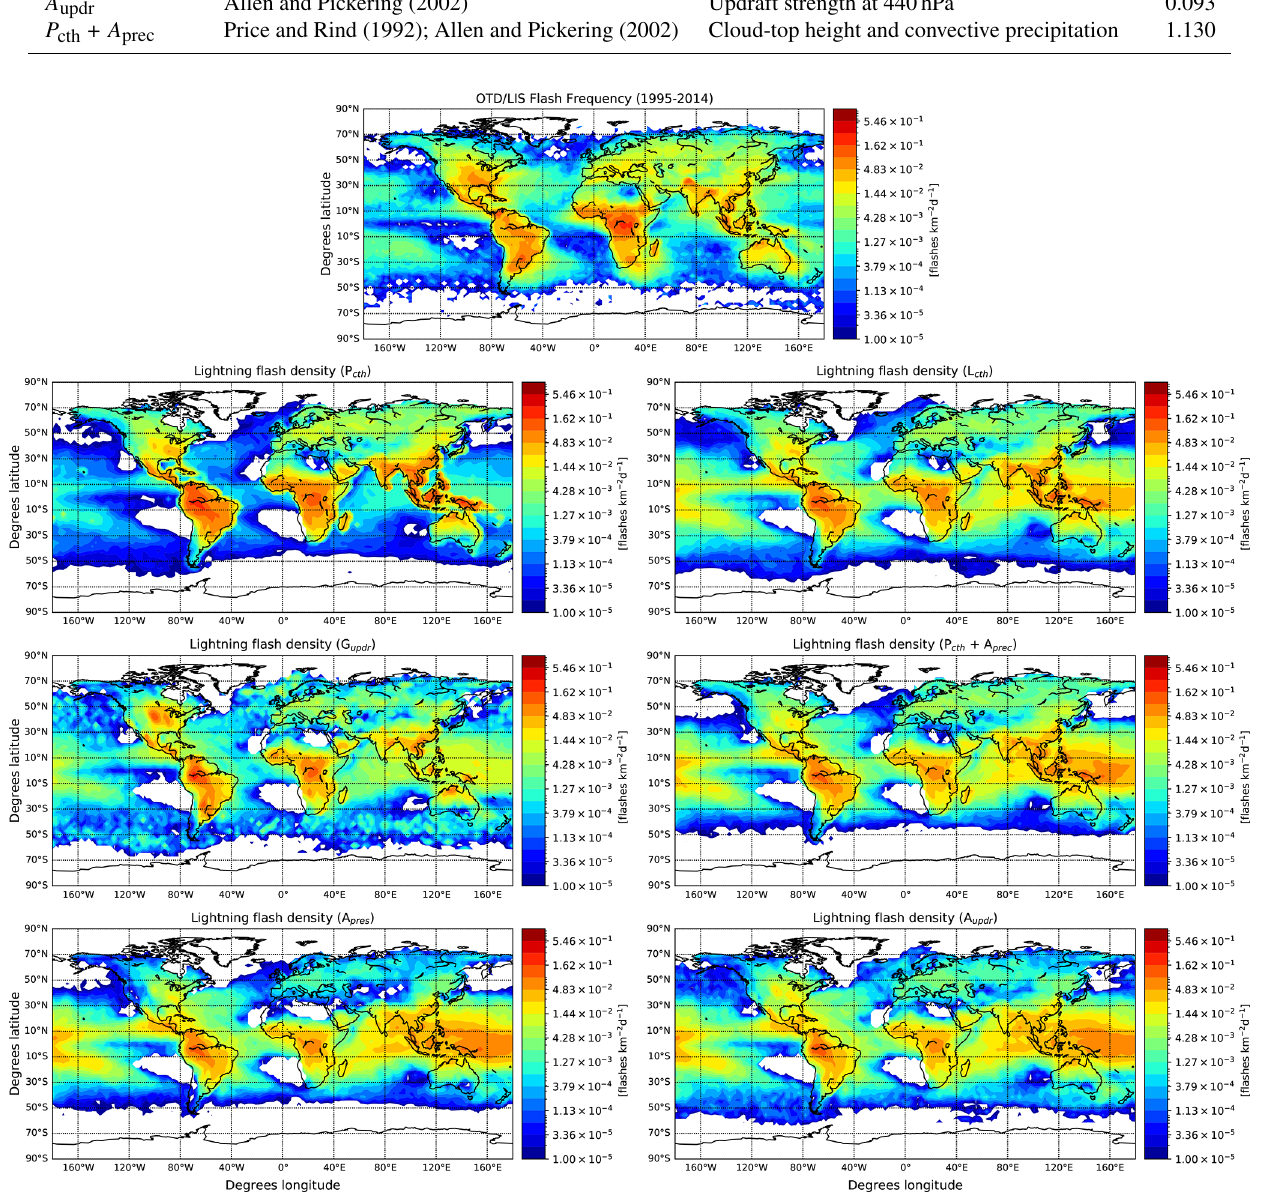
Figure 4. Global annual lightning observations (upper panel) by OTD/LIS using the OTD/LIS Gridded Lightning Climatology Data Collec- tion version 2.3.2015 High-Resolution Monthly Climatology (HRMC) from 4 May 1995 to 31 December 2014 (Christian et al., 2003; Cecil et al., 2014). As in Gordillo-Vázquez et al. (2019), the climatology has been degraded to 2.5 ◦ longitude × 1.9 ◦ latitude resolution. Simulated annual average flash density (remaining panels) between 1 March 2017 and 28 February 2018 using different lightning parameterizations described in Table